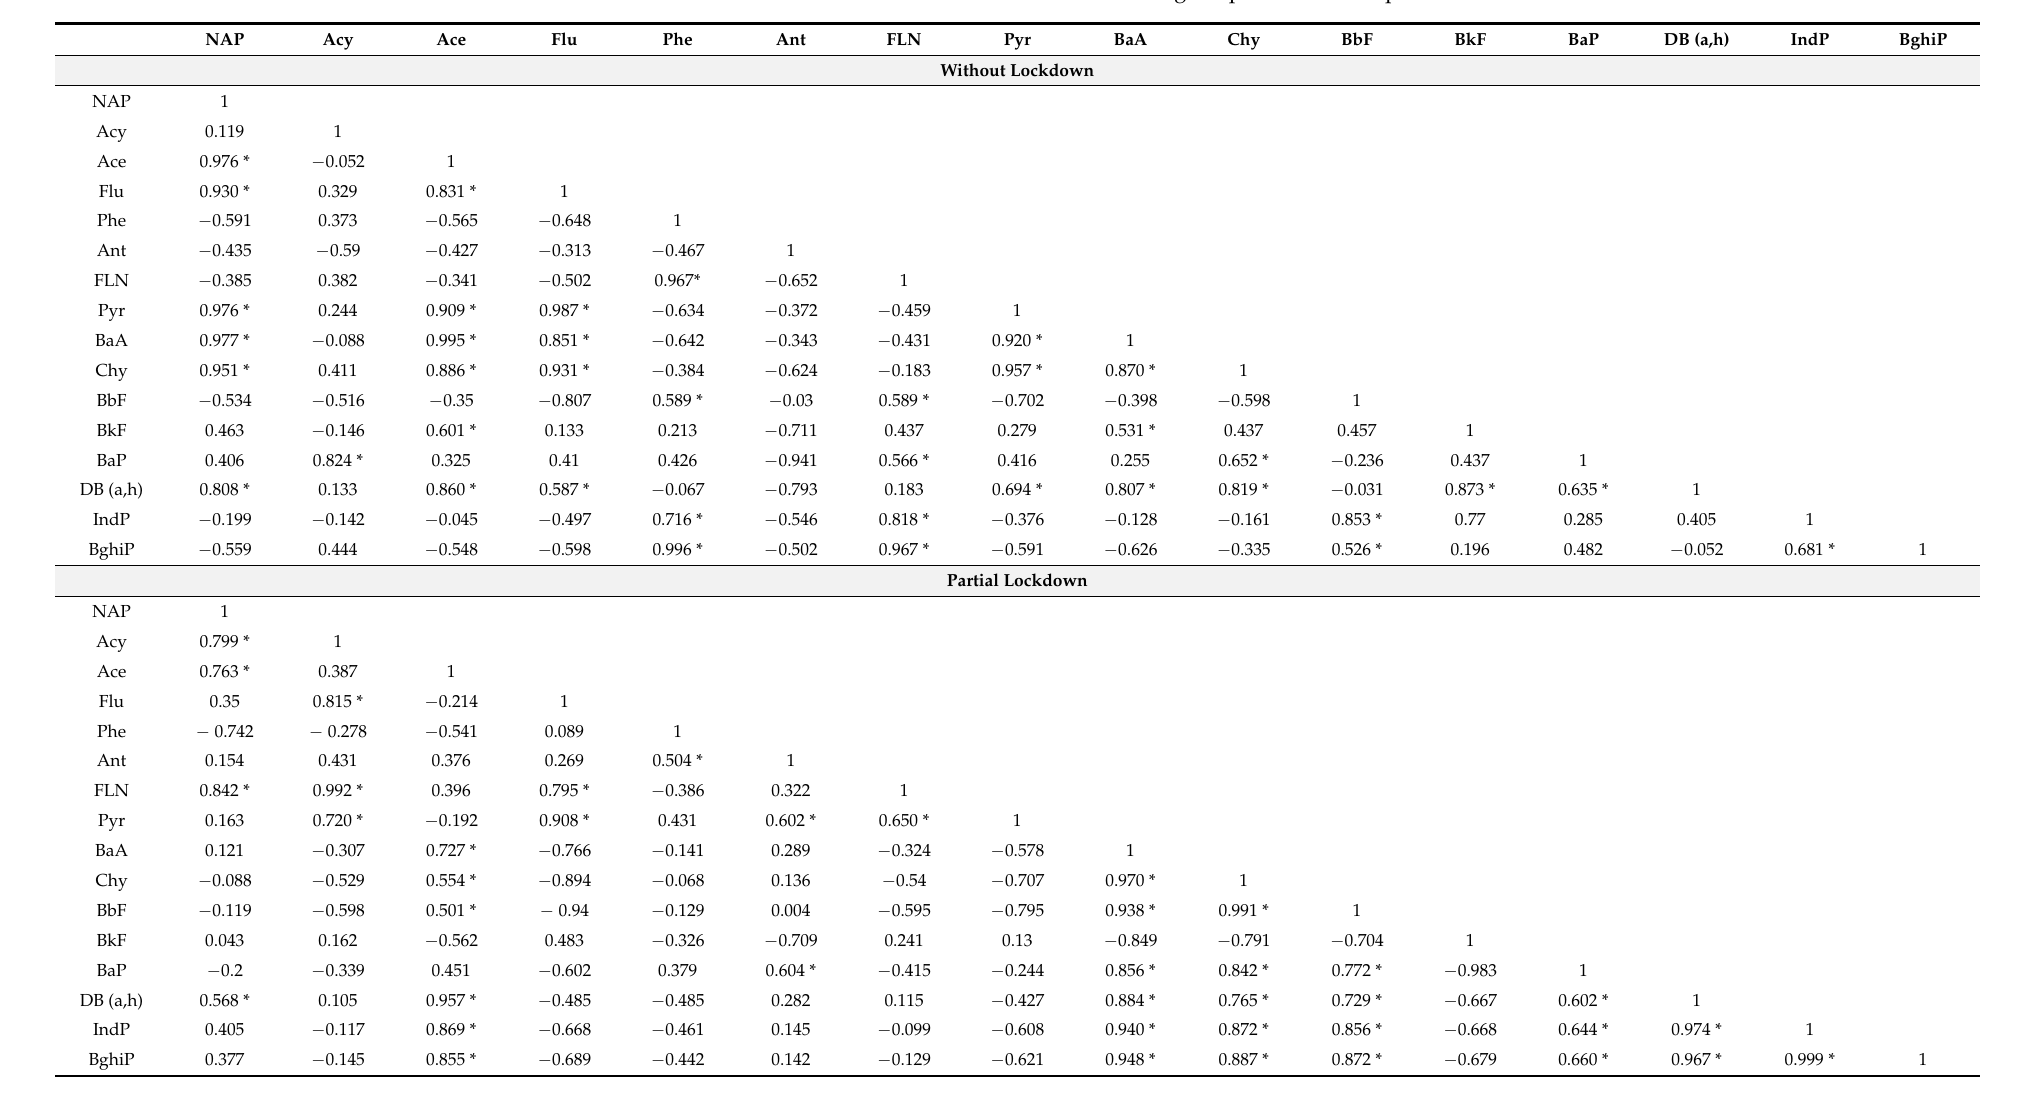
Table 3. Correlation matrix for PAHs in street dust without lockdown and during the partial and complete